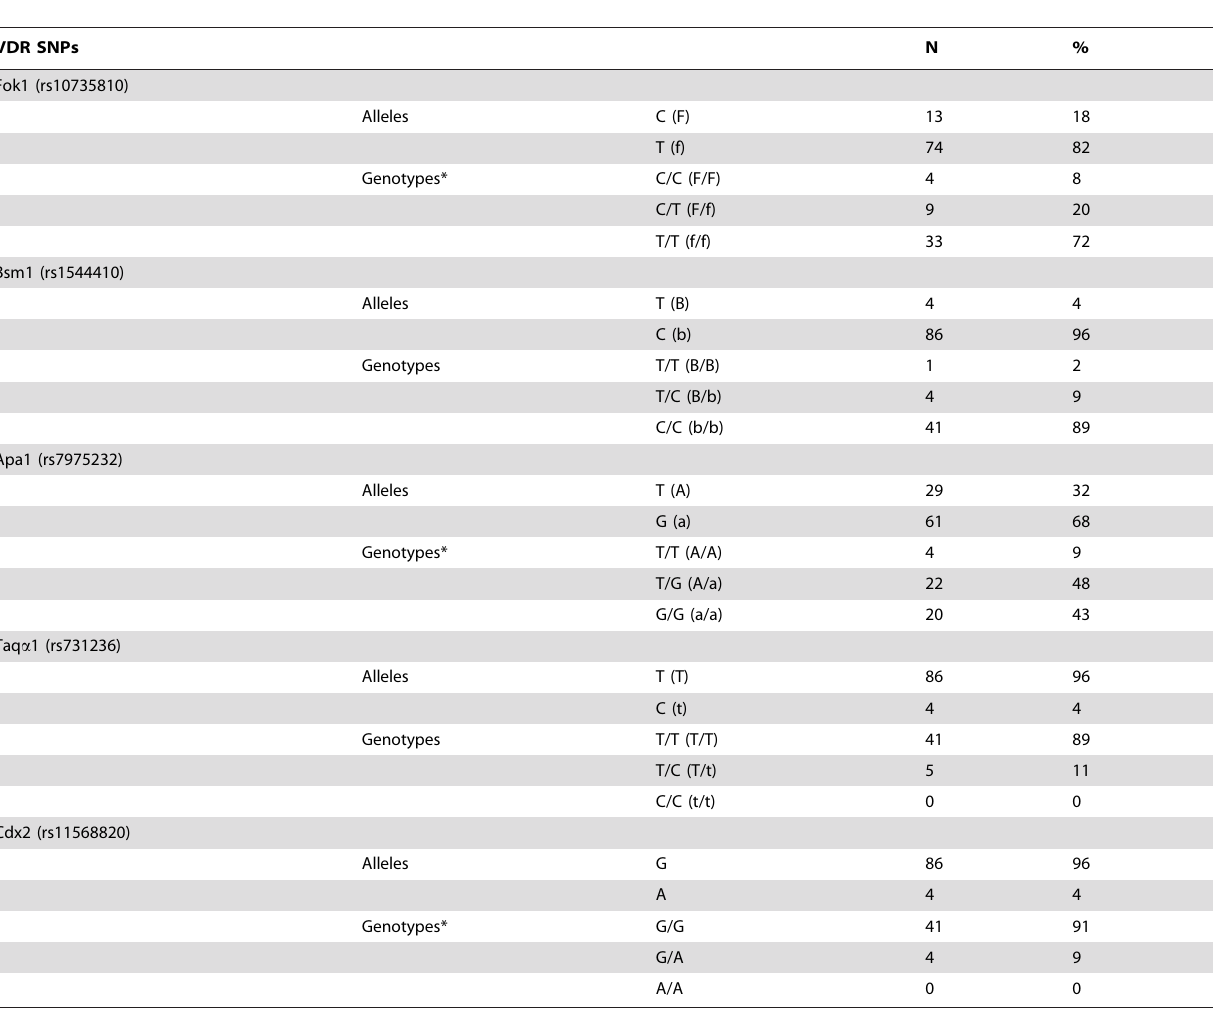
Table 4. Allele and genotype frequencies for the vitamin D receptor gene polymorphisms (Fok1, Bsm1, Apa1, Taq a 1 and Cdx2).